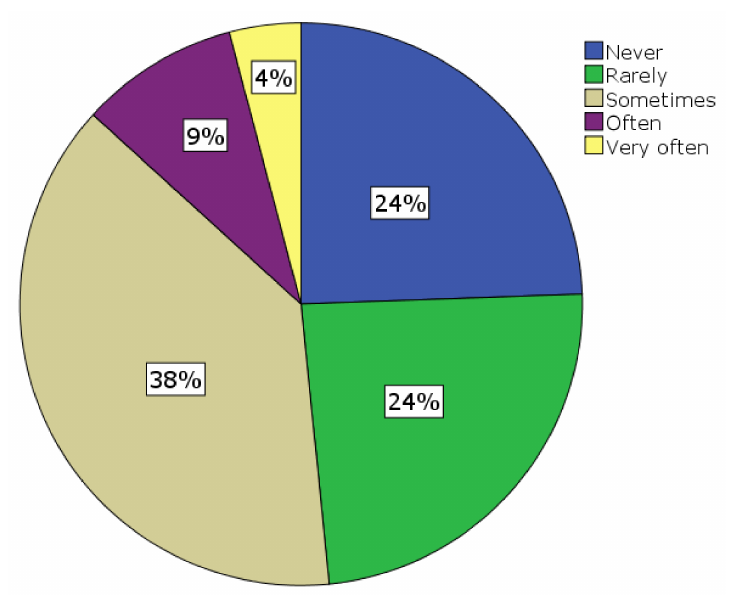
Figure 8. How often does a lack of energy prevent you from walking in Galway?